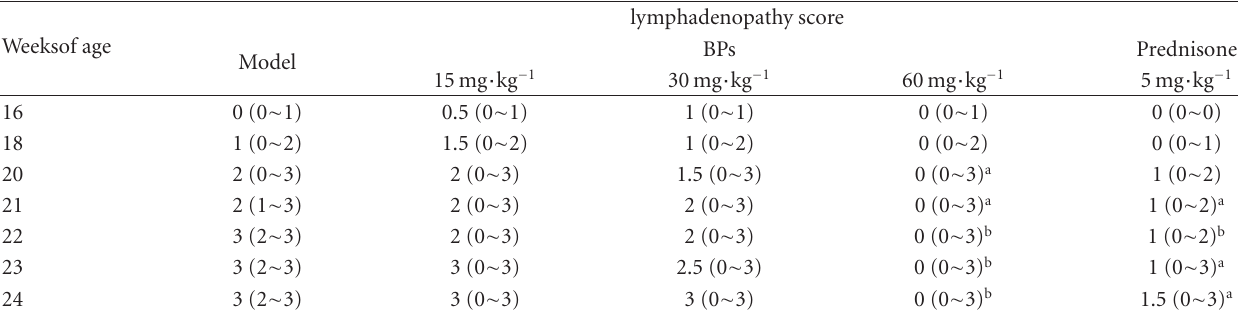
Table 1: E ff ect of BPs on lymphadenopathy of MRL-lpr mice.